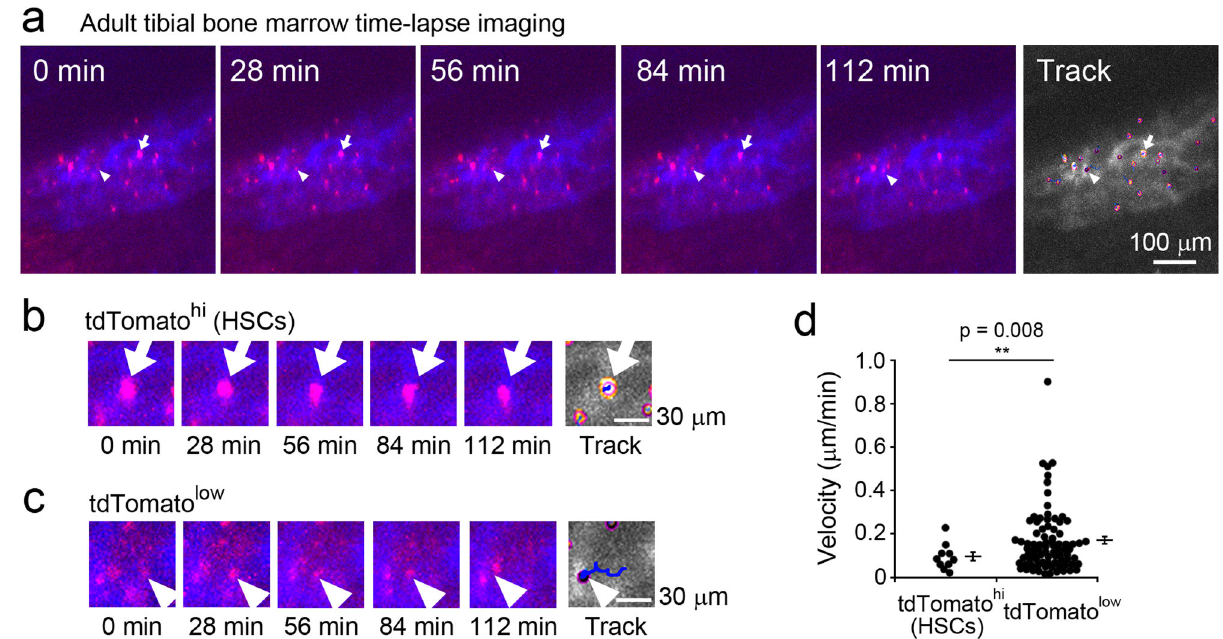
Fig. 4 Time-lapse imaging of Hlf-tdTomato-labeled cells in the tibial bone marrow. a Hlf-tdTomato-positive cells in the tibial bone marrow were imaged for 2 h in vivo. Arrows indicate Hlf-tdTomato hi HSCs and arrowheads indicate Hlf-tdTomato low cells. See also Supplementary Movie 3. b Higher magni fi cation time-lapse images of Hlf-tdTomato hi HSCs. c Higher magni fi cation time-lapse images of Hlf-tdTomato low cells. d Quantitative comparison of the migration dynamics between Hlf-tdTomato hi cells (ten cells from fi ve mice) and Hlf-tdTomato low cells (81 cells from fi ve